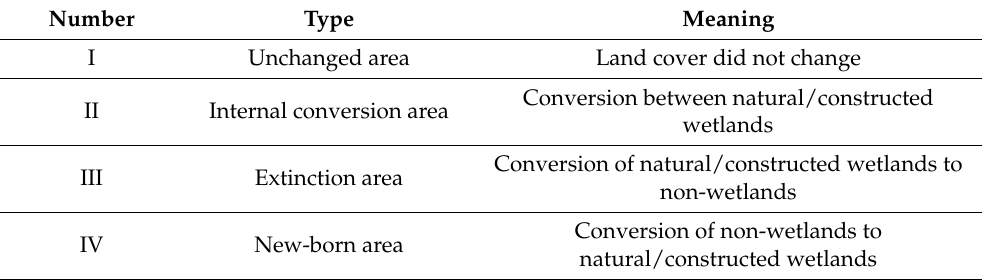
Table 7. Comparison of primary classification change patterns.